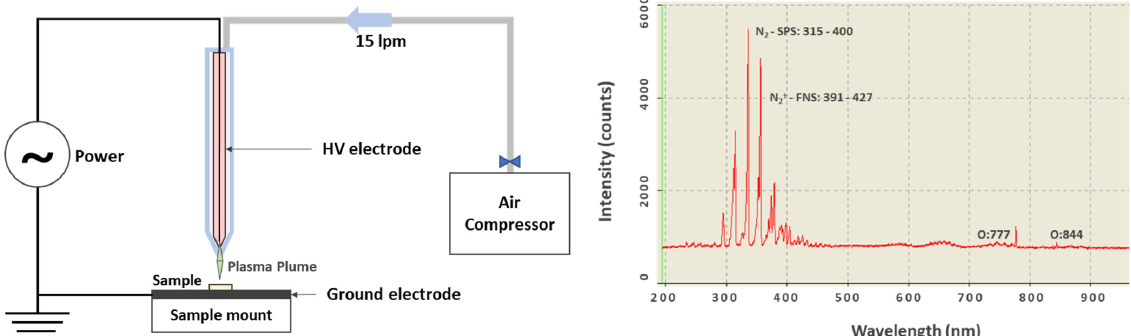
Figure 1. Schematic diagram of experimental setup with air plasma jet system ( left ) and the optical emission spectrum. ( right ). The spectrum is dominated by emissions from the second positive system (SPS) of molecular nitrogen (N 2 at 315–400 nm), the first negative system (FNS) of N 2+ (391–427 nm), and atomic oxygen (777 and 844 nm).